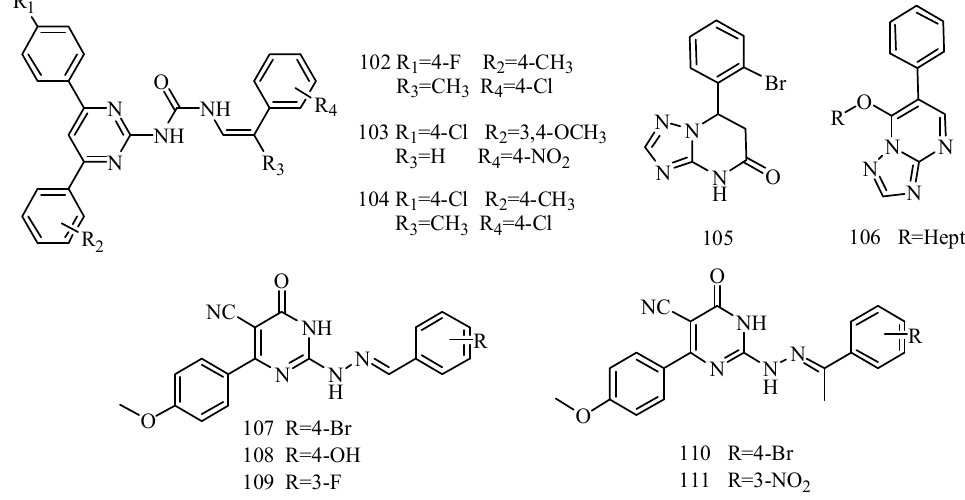
Figure 7. Structures of compounds 102 – 111 .